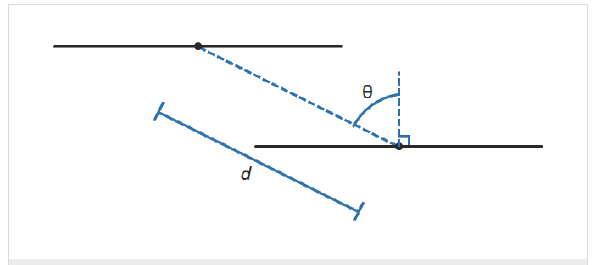
Figure 5: Schematic of the parameters used for comparing X-ray crystal structures, view is parallel to the molecular plane. Black lines represent the molecules with circles denoting the